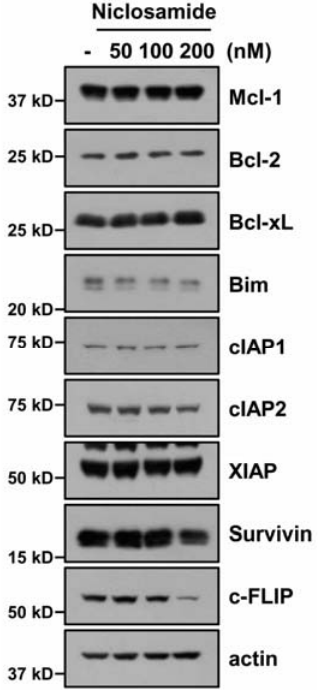
Figure 2. Niclosamide decreases levels of c-FLIP expression. Protein expression was detected by Western blotting in Caki cells after treatment with niclosamide (50–200 nM) for 24 h.